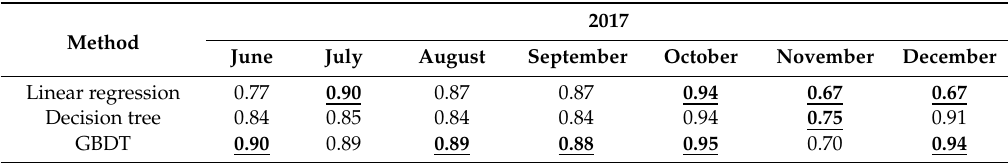
Table 14. Correlation coe ffi cient for each method per month. (bold and underline means a best value of each month).